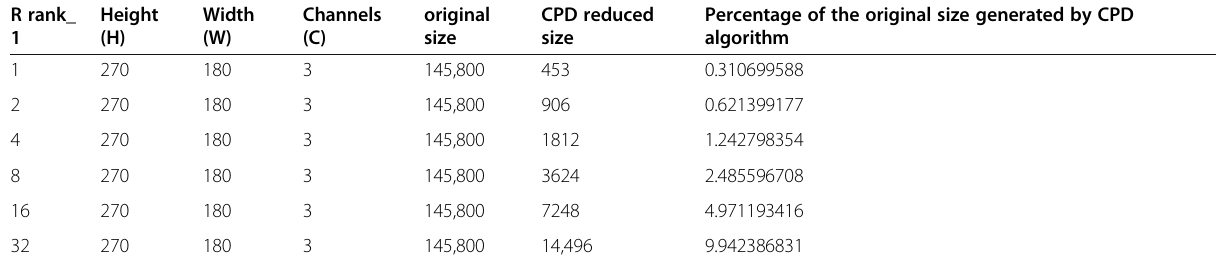
Table 2 Result of IoTCP_DL algorithm with different values of R Rank_1